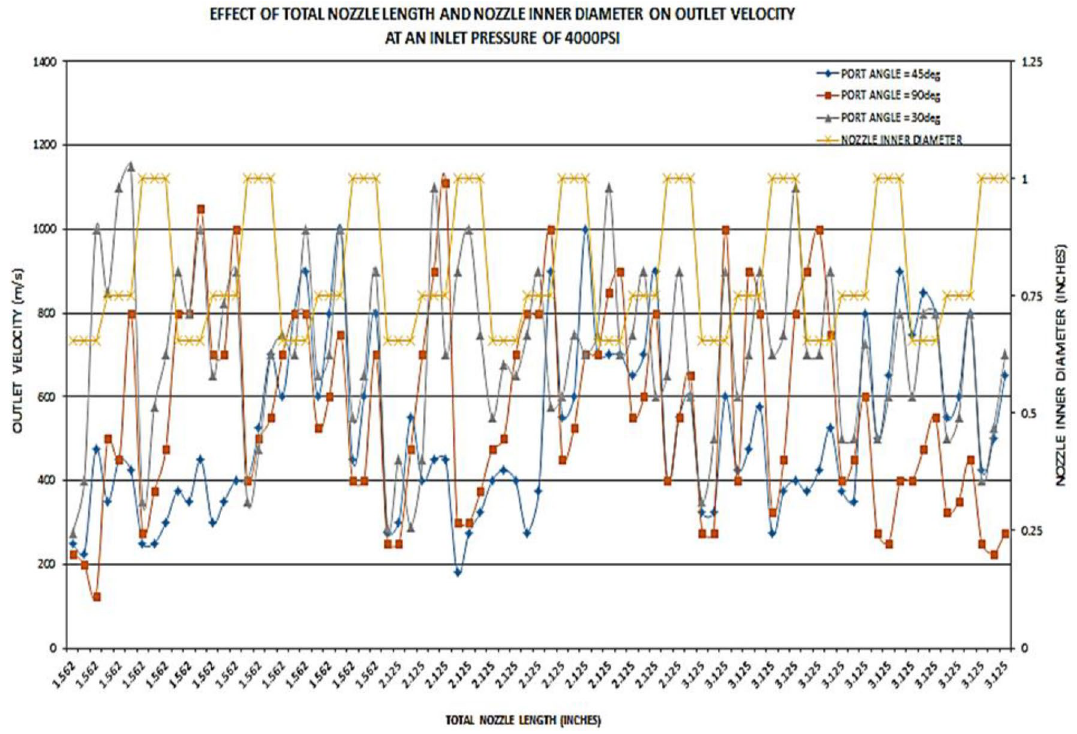
Fig. 13 Effect of total nozzle length and nozzle inner diameter on outlet velocity at an inlet pressure of 4000